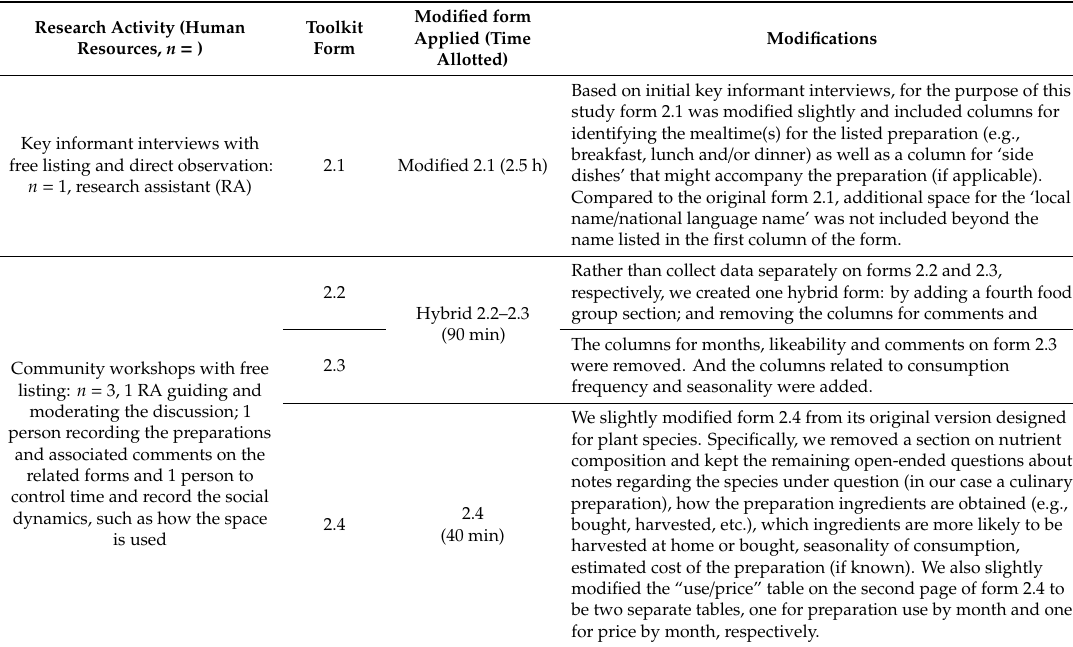
Table 2. Summary modifications to study instruments compared to the original “toolkit” ‡ . Research Activity (Human Resources, n =